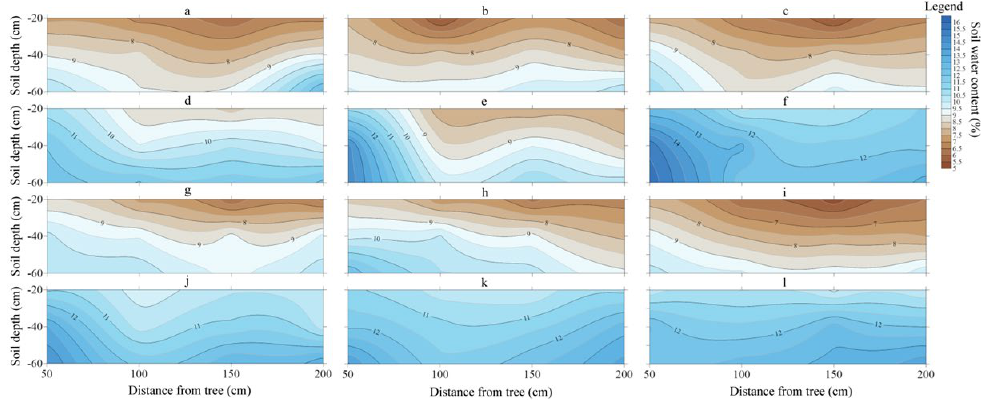
Figure 2. Two−dimensional soil moisture content distribution in different stages of monocropping apple and ryegrass apple intercropping system (( a , d , g , j ): flowering and fruiting period; ( b , e , h , k ): fruit enlarging period; ( c , f , i , l ): fruit maturing period; monocropping apple (first and third rows) and ryegrass apple intercropping system (second and fourth rows); in the 2020 (top two rows) and 2021 (bottom two rows) seasons).